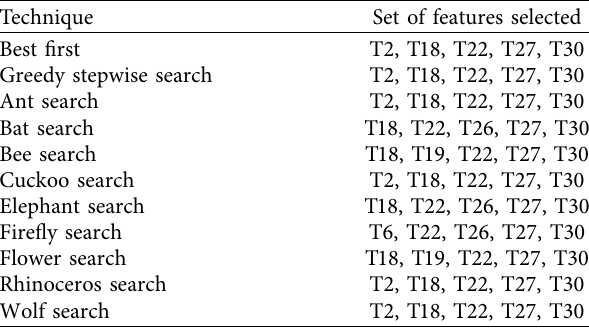
Table 7: Feature subset selection results for dataset A.